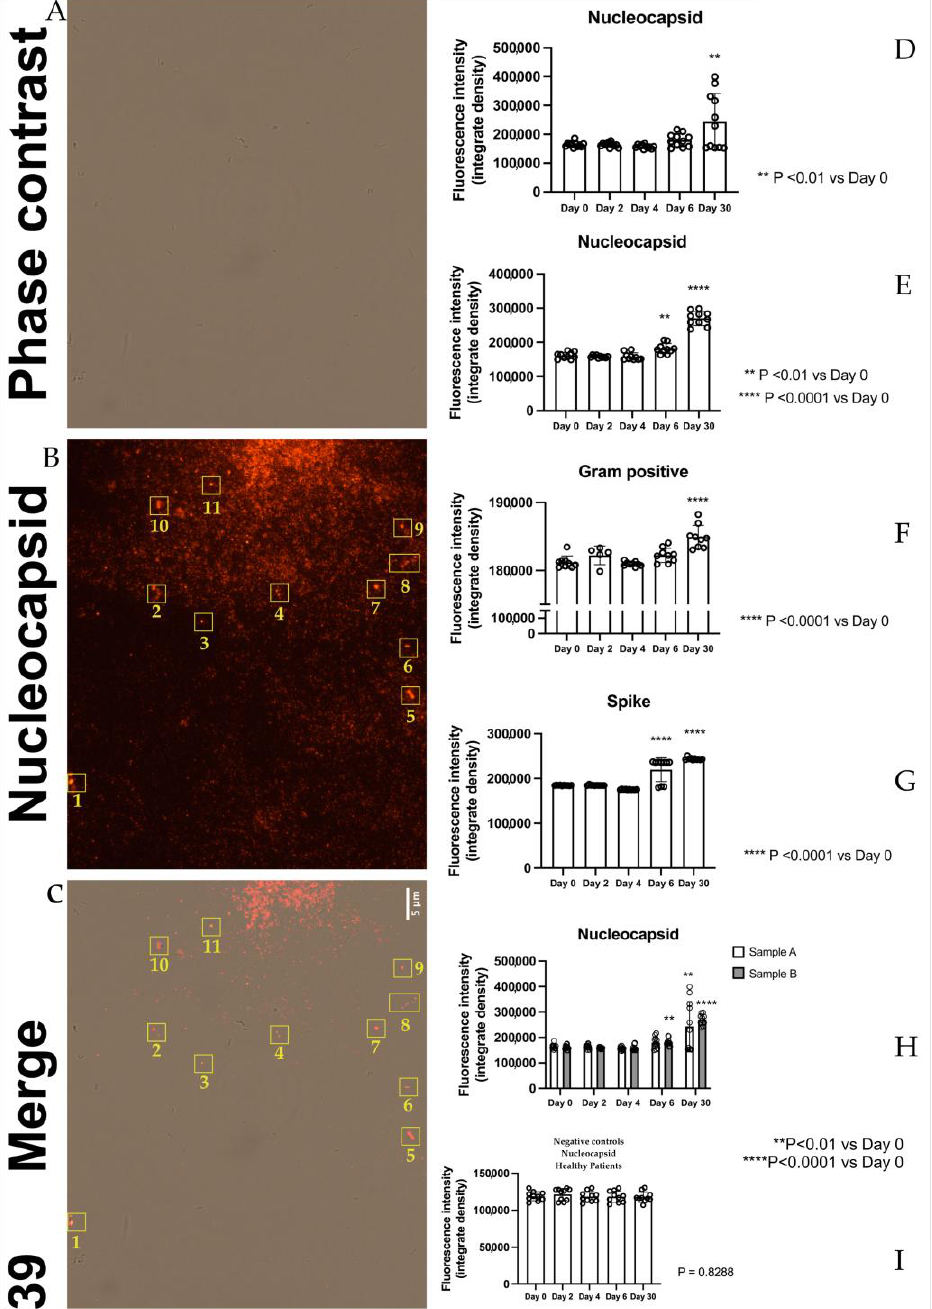
Figure 1. Panel A: Bacteriophage behavior of SARS-CoV2 by immunofluorescence. Panel A – C: Dorea formicigenerans strains (DSM Numbers 3992) infected by SARS-CoV-2. Panel A shows the phase contrast image. Panel B shows an image of the Dorea F . cultures in which supernatant was added with SARS-COV-2, and antibodies against nucleocapsid proteins were detected. Panel C shows merged images: the rectangles numbered 1 – 11 show Dorea F . bacteria merging with the signal of nucleocapsid proteins of the virus. Scale bar, 5 μ m. Panel D : SARS-CoV-2 nucleocapsid protein – fluorescence analysis in samples A ( 1, 2….10) . The graph shows the quantification of nucleocapsid fluorescence in- tensity expressed as integrated density within the analyzed samples. ** p < 0.01 versus Day 0. Panel E SARS-CoV-2 nucleocapsid protein fluorescence analysis in samples B (1,2,…..10) . The graph shows the quantification of nucleocapsid fluorescence intensity expressed as integrated density within the an- alyzed samples. ** p < 0.01 **** p < 0.0001 versus Day 0. Panel F : gram-positive protein fluorescence analysis in samples C (1,2,…..10) . The graph shows the quantification of gram-positive fluorescence in- tensity expressed as integrated density within the analyzed samples. **** p < 0.0001 versus Day 0. Panel G : SARS-CoV-2 spike protein fluorescence analysis in samples A (1, 2…..10) . The graph shows the